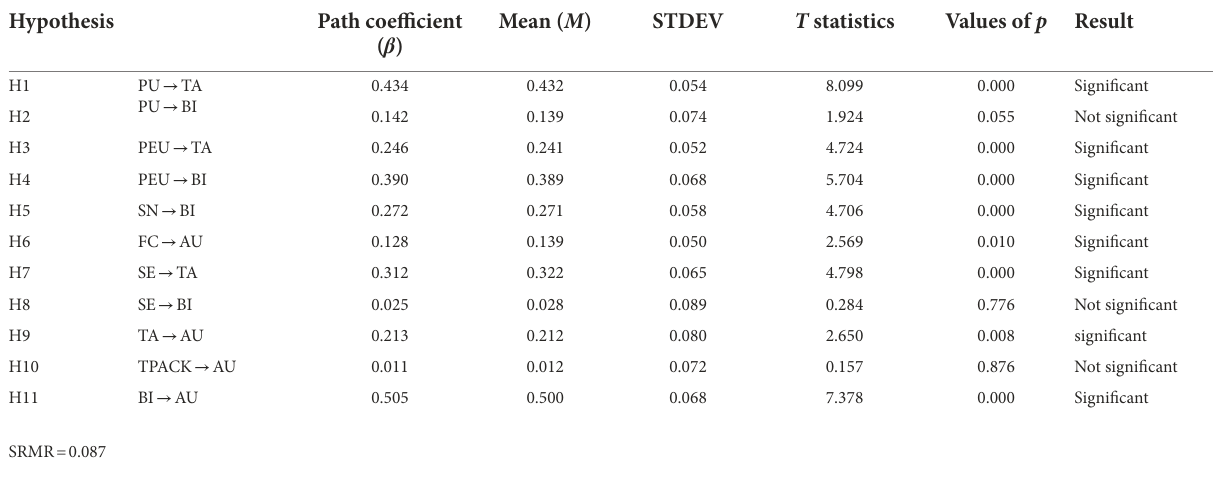
TABLE 6 Summary of hypothesis testing